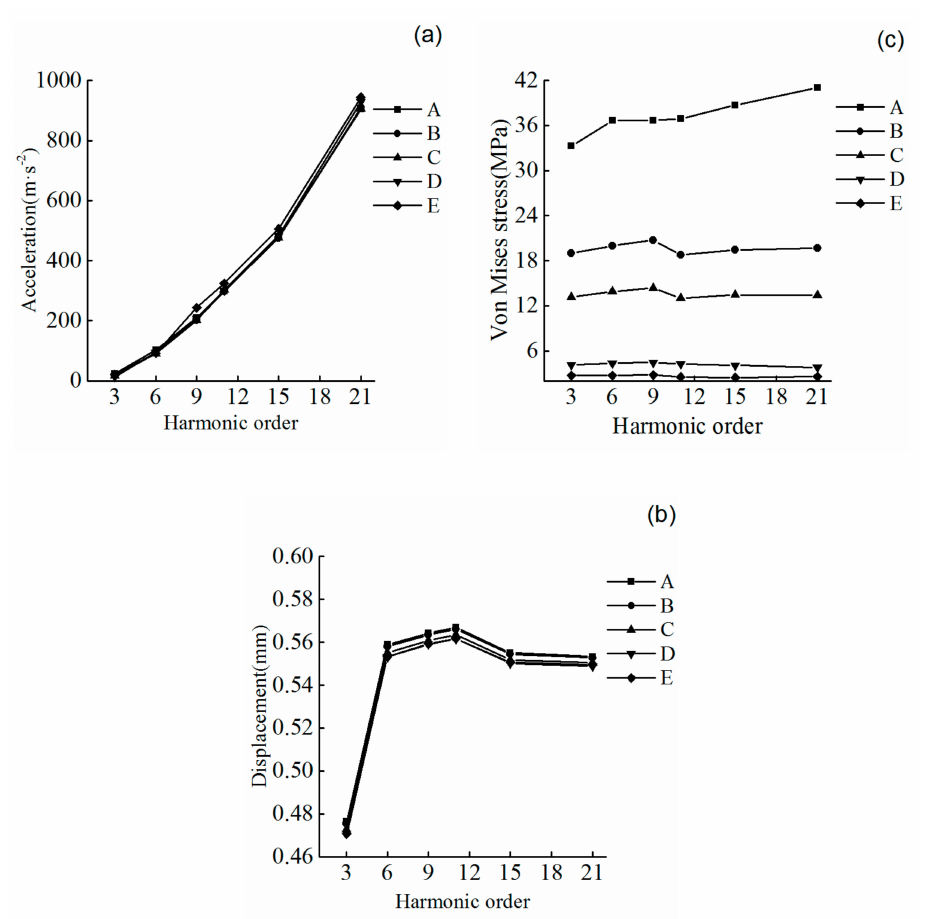
Figure 11. E ff ects of harmonic order on rail dynamics: ( a ) acceleration versus order, ( b ) displacement versus order, and ( c ) von Mises equivalent stress versus